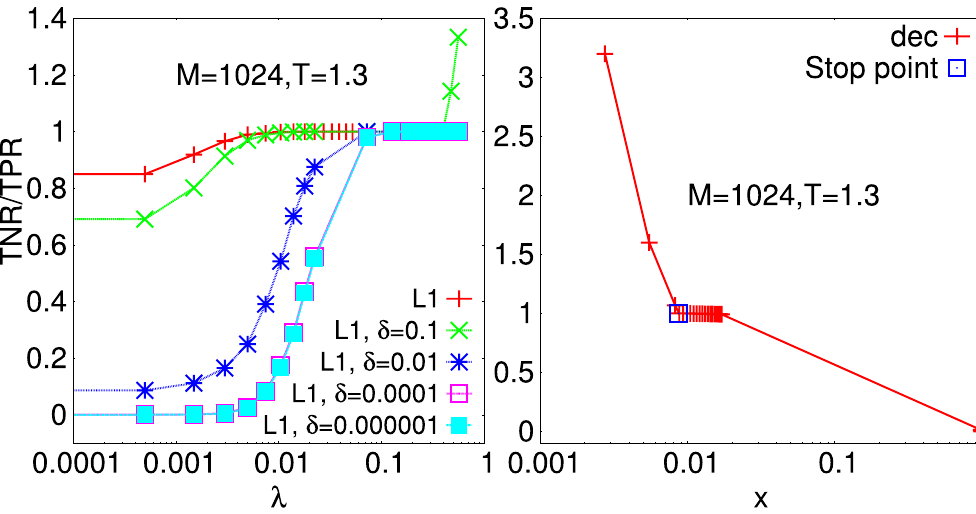
-regularization (left) and vs. the fraction x of 1 , Eq. (13), t